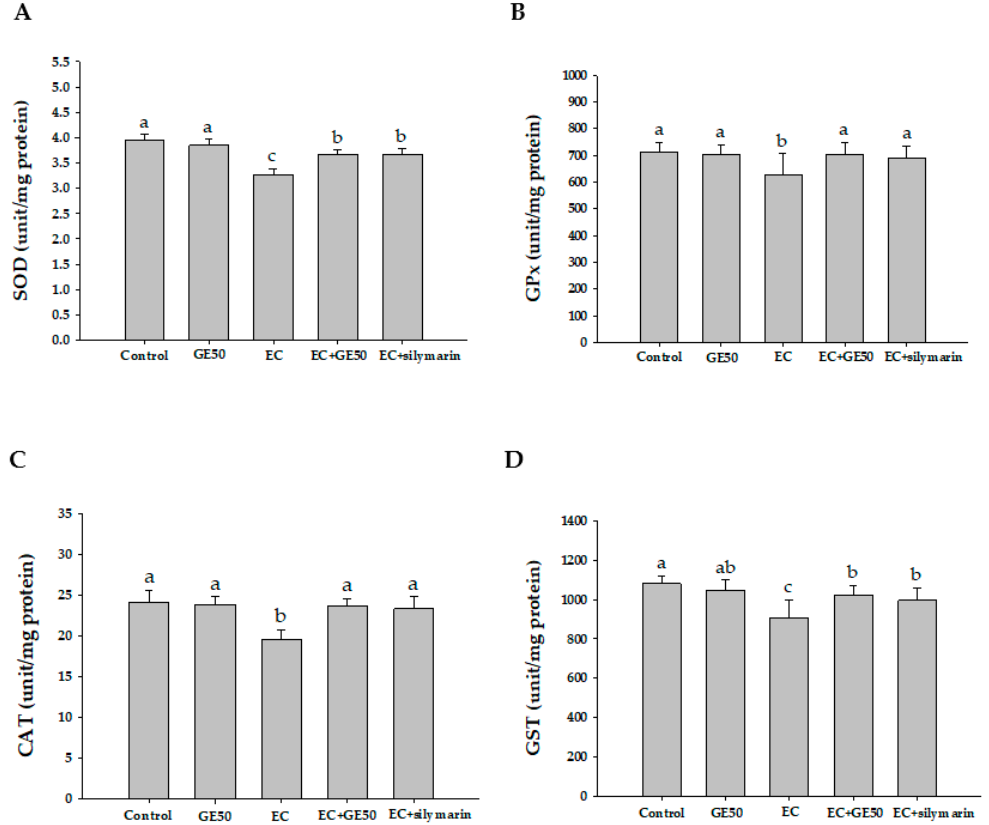
Figure 3. Effects of oral administration of GE50 over six consecutive weeks on superoxide dismutase (SOD) ( A ), glutathione peroxidase (GPx), ( B ), catalase (CAT), ( C ), and glutathione S-transferases (GST) ( D ) activities in the livers of rats treated with ethanol + CCl 4 . The data are presented as mean ± S.D. of 10 rats. One-way ANOVA and Scheffe’s method were used to analyze the differences between the means. a–c Mean values with different letters in the same row are significantly different ( p < 0.05) according to Duncan’s multiple-range test. Control group; GE50 group; EC group: Ethanol + CCl 4 ; EC + GE50 group: Ethanol + CCl 4 + GE50; EC + silymarin group: ethanol + CCl 4 + silymarin.